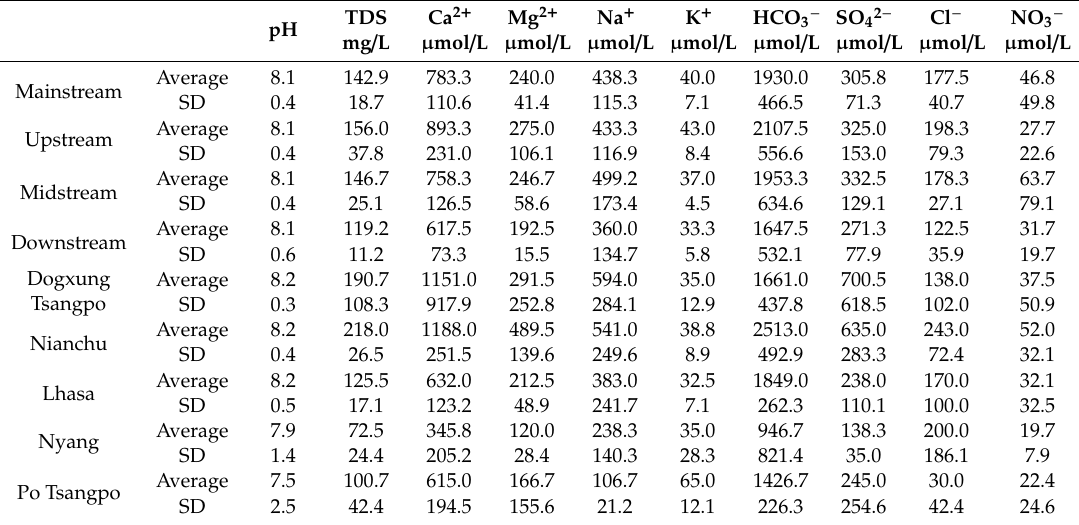
Table 2. Summary of the chemical components of the mainstream and tributaries in the Yalung Tsangpo River Basin (annual mean value).